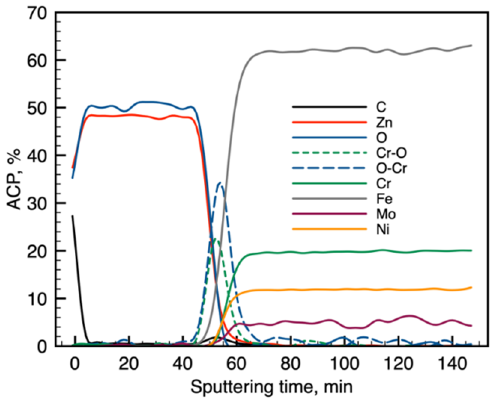
Figure 4. Electropolished 1500_300: calculated atomic concentration in the depth profile.